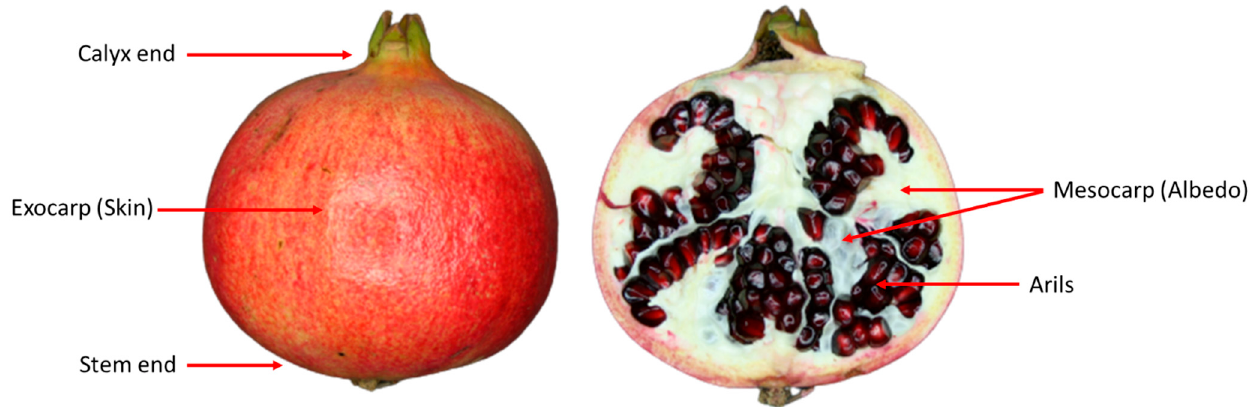
Figure 1. Structure of a typical pomegranate fruit variety ‘Wonderful’ right after harvest including external structures (i.e., calix end, stem end, and exocarp tissue or skin) and internal structures (e.g., mesocarp tissue or albedo and arils or seeds).